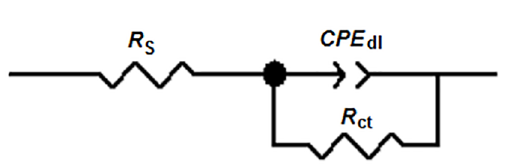
Figure 5. Electrical equivalent circuit used to fit the EIS results of CS-ASTM 1020 in 18.23 g L -1 HCl solution in the absence and in the presence of 1.112 g L -1 inhibitors.